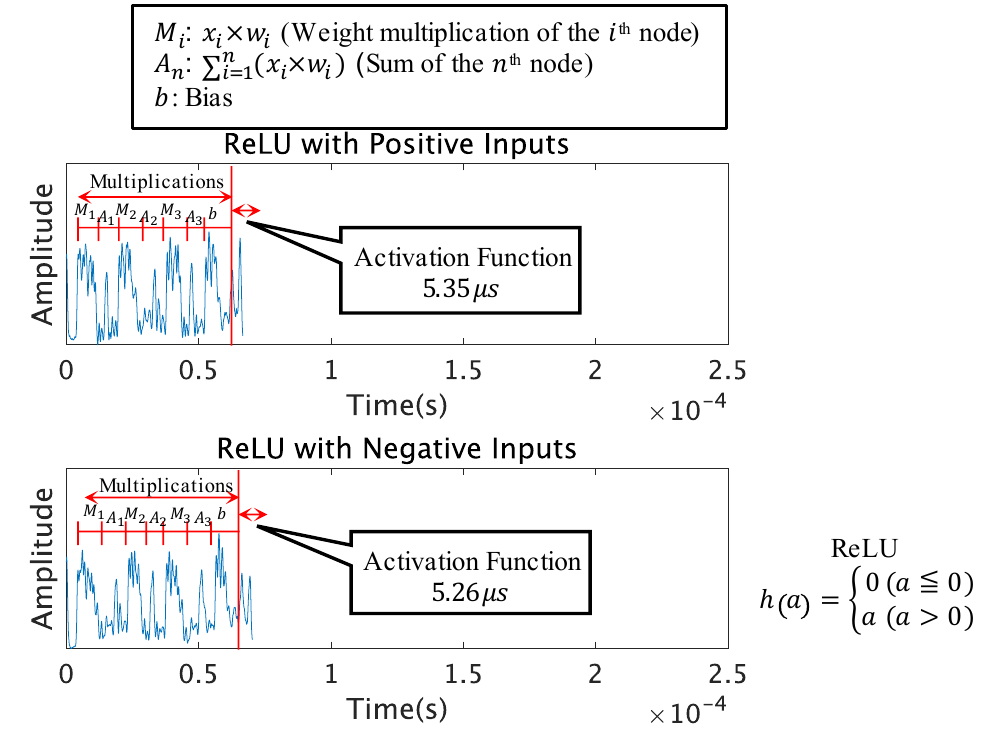
Figure 6. Extracted Pattern Measurements of the ReLU Function.